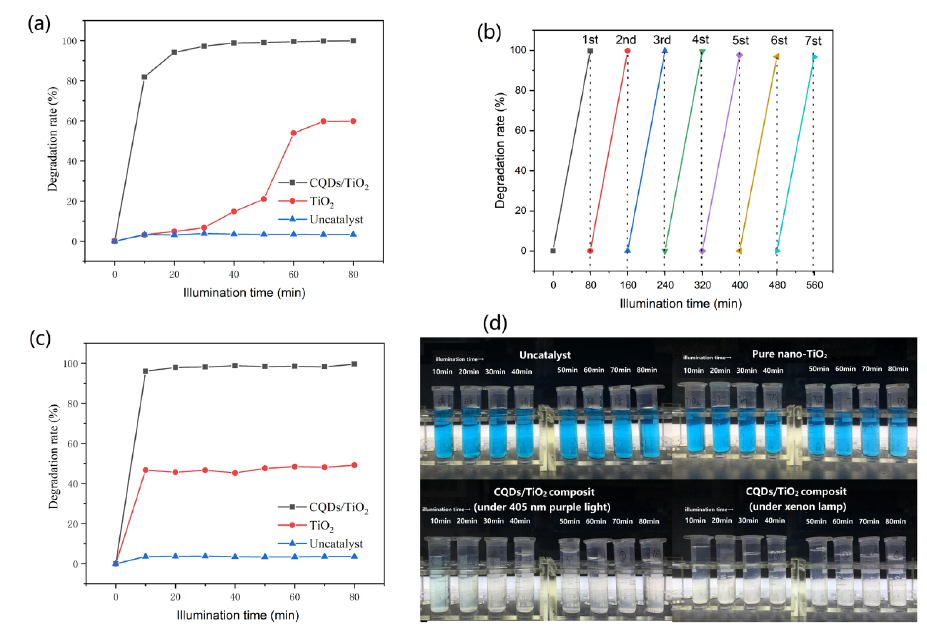
Figure 8. ( a ) The photocatalytic degradation rate of CQDs/TiO 2 composite and pure TiO 2 to methylene blue within different irradiation times under 405 nm purple light; ( b ) the photocatalytic deg- radation rate of CQDs/TiO 2 composite of the different photocatalytic cycle with 80 min as a working cycle; ( c ) the photocatalytic degradation rate of CQDs/TiO 2 composite and pure TiO 2 methylene blue within different irradiation time under a xenon lamp; ( d ) the photographs showing the photocata- lytic degradation effects on methylene blue of CQDs/TiO 2 composite and pure TiO 2 .